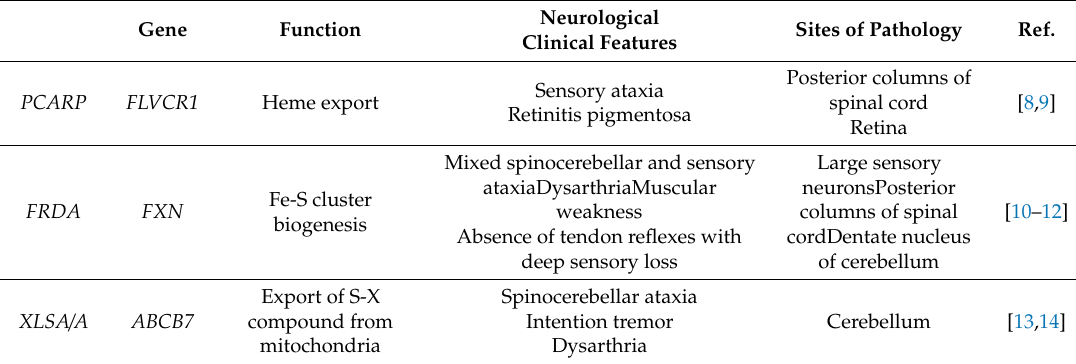
Table 1. Main clinical features and sites of pathology of PCARP, FRDA and XLSA /